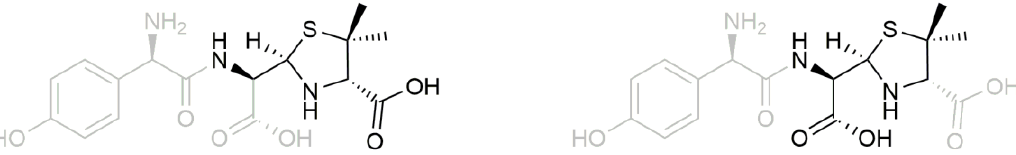
Figure 15. Two possible positions of fragment m / z 189 ions in amoxicilloic acid.